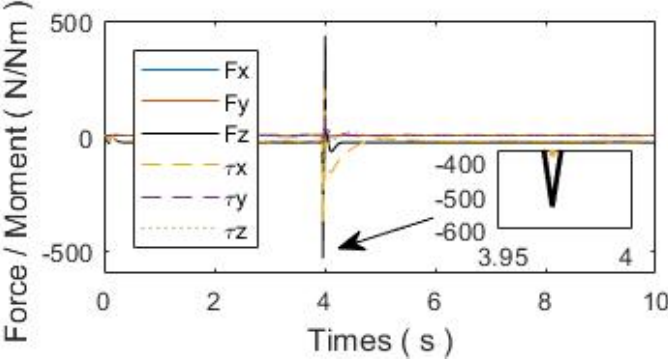
Figure 10. Disturbance of the base in experiment 2.